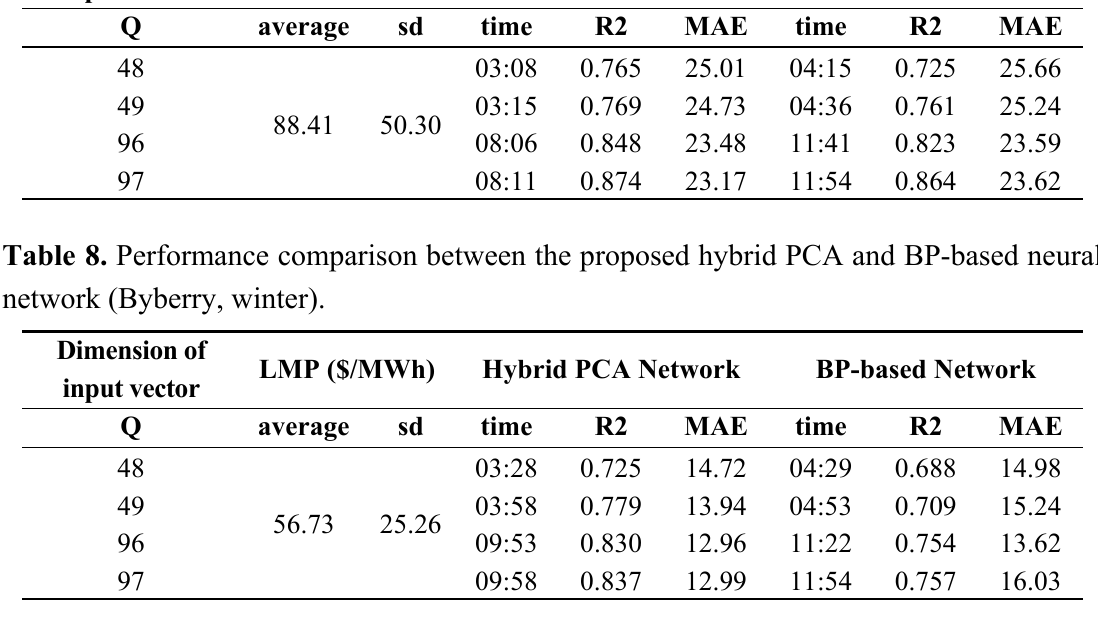
Figure 7. Comparisons among actual, BP-based and hybrid PCA-based LMPs for